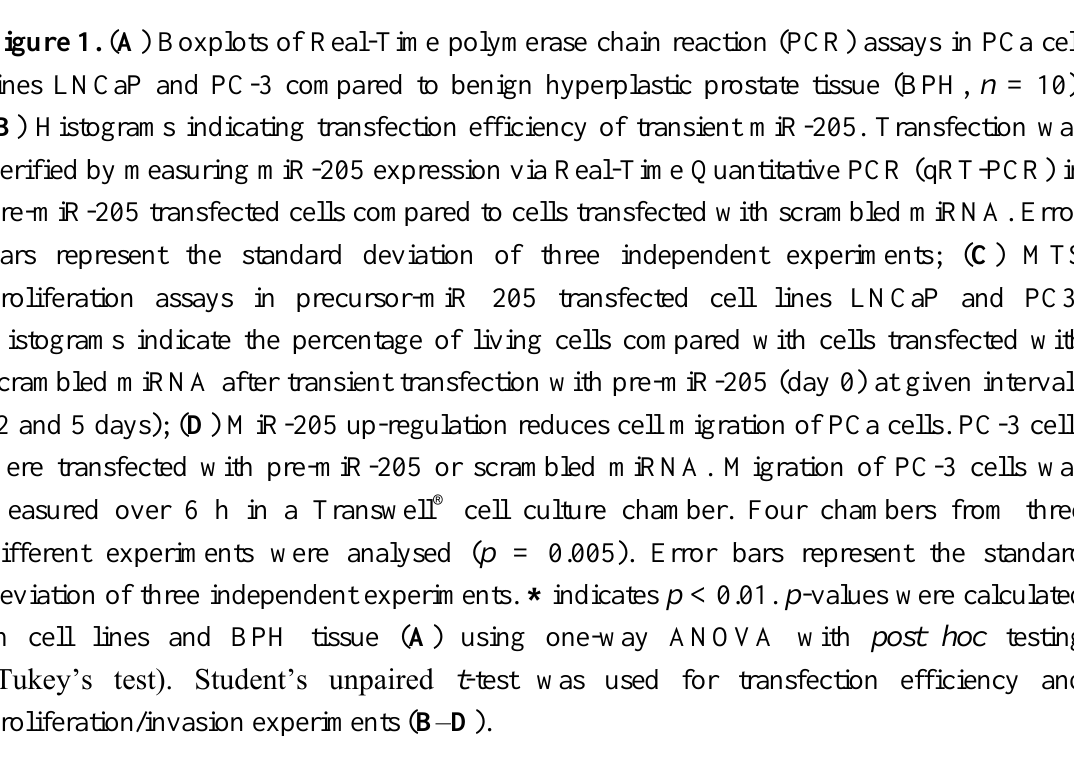
Figure 1. ( A ) Boxplots of Real-Time polymerase chain reaction (PCR) assays in PCa